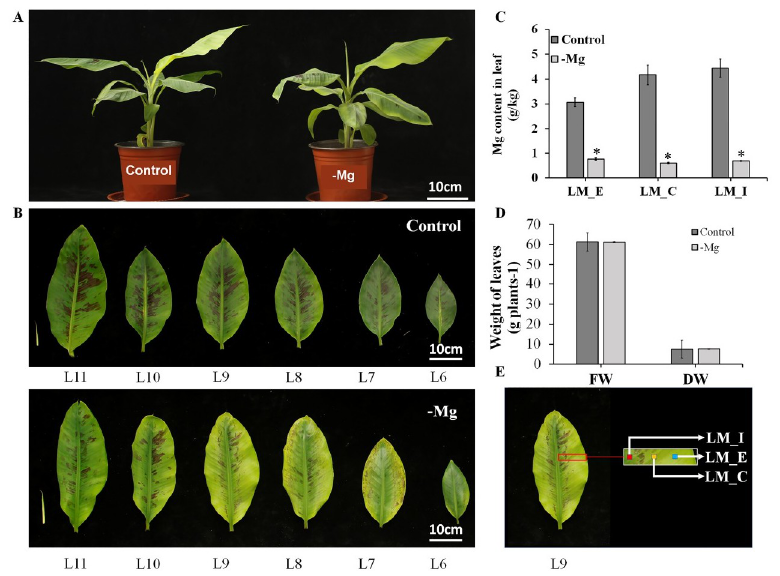
Fig 1. Phenotypes and Mg contents of banana ( Musa acuminata ) leaves under long-term MD. (A) The phenotype of banana seedlings after MD for 42 days. For the control groups, 1 mM Mg 2+ Hoagland nutrient solutions were used, and 0 mM Mg 2+ solutions were used for the long-term MD treatment (-Mg). Scale bars = 10 cm. (B) The phenotype of the 7 th – 11 th banana seedling leaves between the control and the MD treatment. Scale bars = 10 cm. (C) Mg content in different parts of the 9 th leaves (L9) ( n = 3). (D) Fresh weight and dry weight of 9 th leaf. FW: fresh weight, DW: dry weight. Values represent the mean ± standard error (SE) ( n = 3). (E) The different parts of the 9 th leaf were collected for RNA-seq. LM_I represents leaf interior, LM_E represents leaf edge and LM_C represents leaf center. Data analysis was performed by two-tailed t test , � means significantly different.